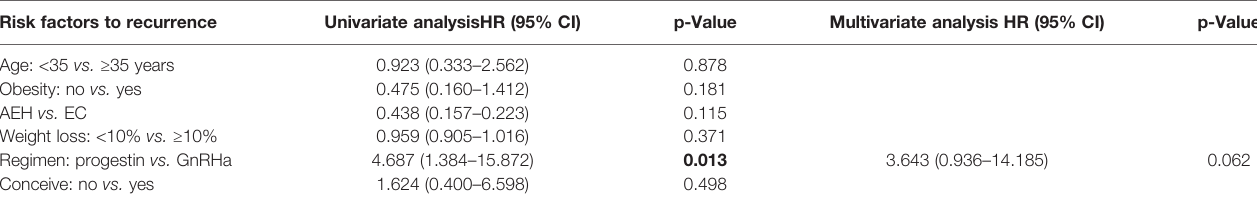
TABLE 3 | Predictors of recurrence.